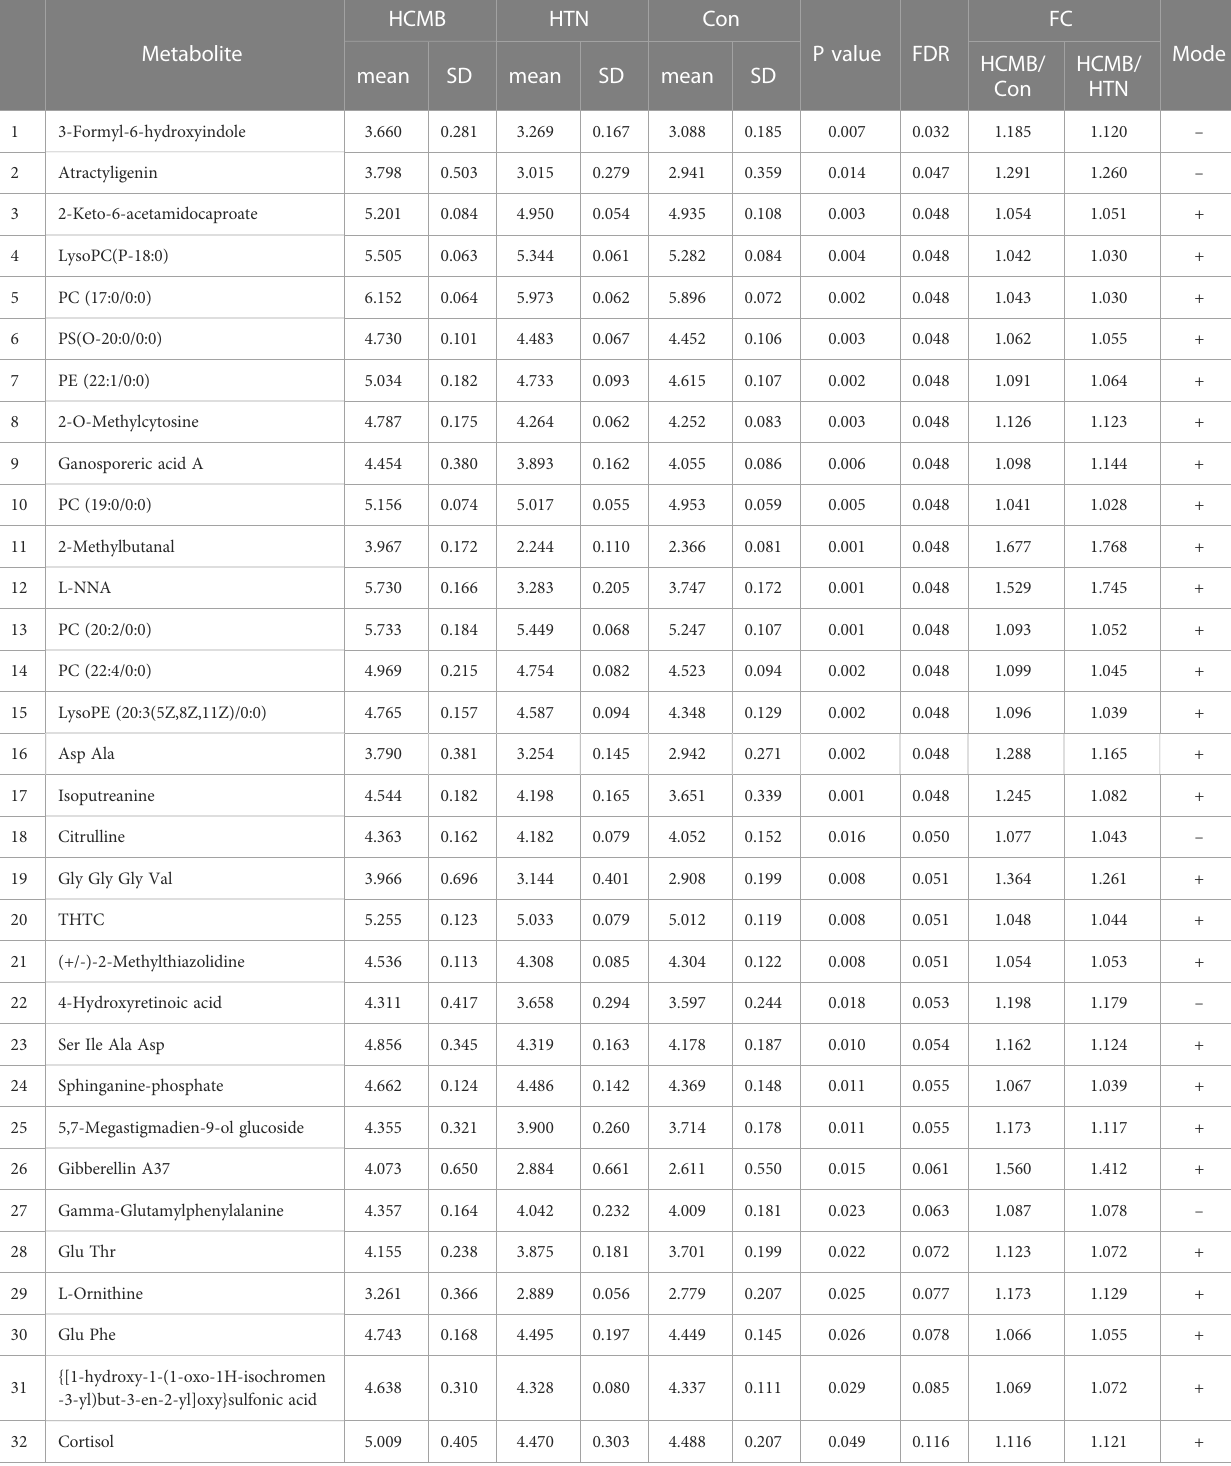
TABLE 1 LC-MS analysis of metabolites upregulated in the HCMB group compared to the HTN and Con groups by the rank-sum test.